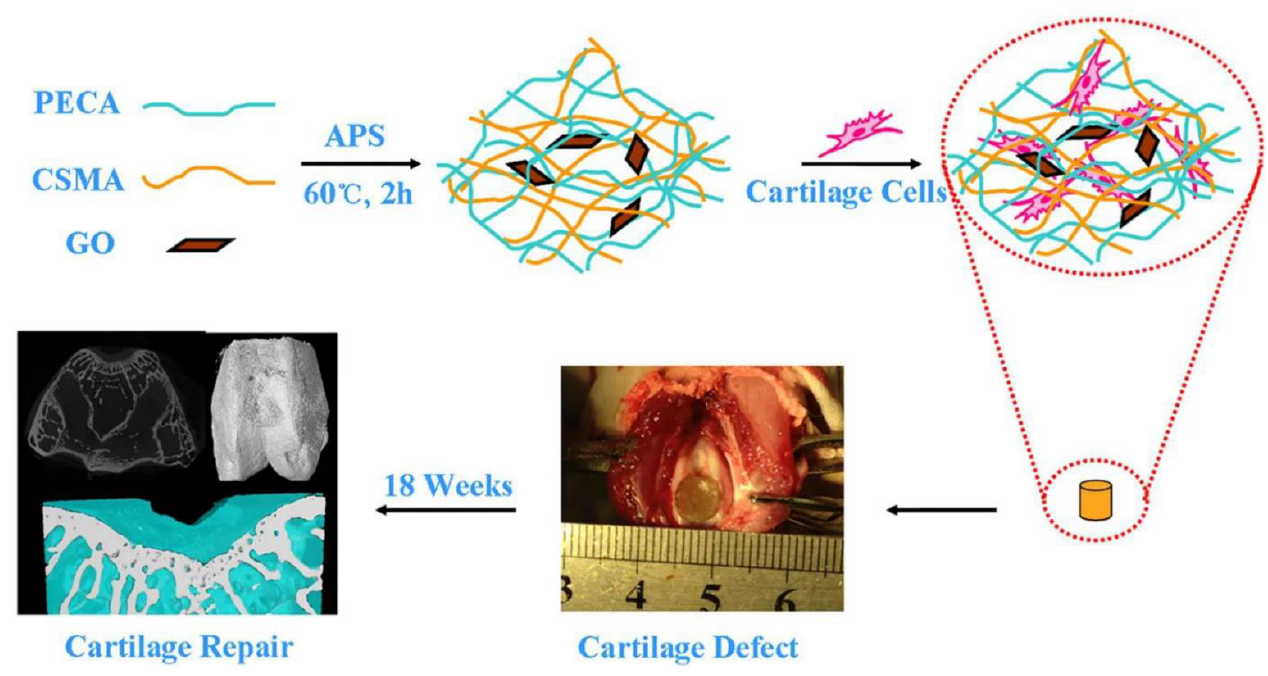
Figure 10. CSMA/PECA/GO hybrid scaffold in bone tissue engineering application (cartilage repairing) [210].